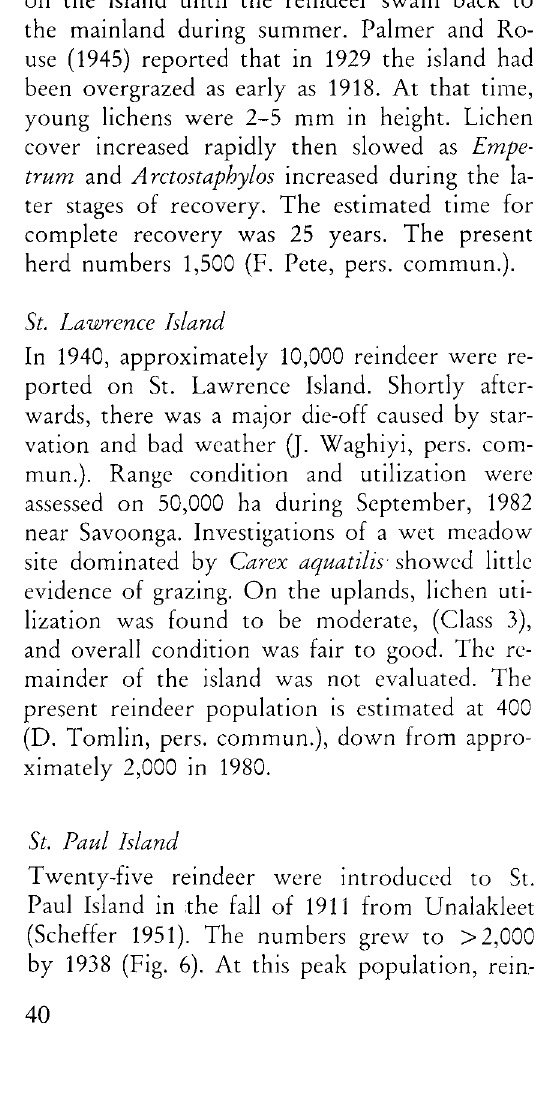
Fig. 6. St. Paul Island, Alaska, reindeer population, 1911-1991. (source: Scheffer 1951 and Davey 1963, 1970-1988